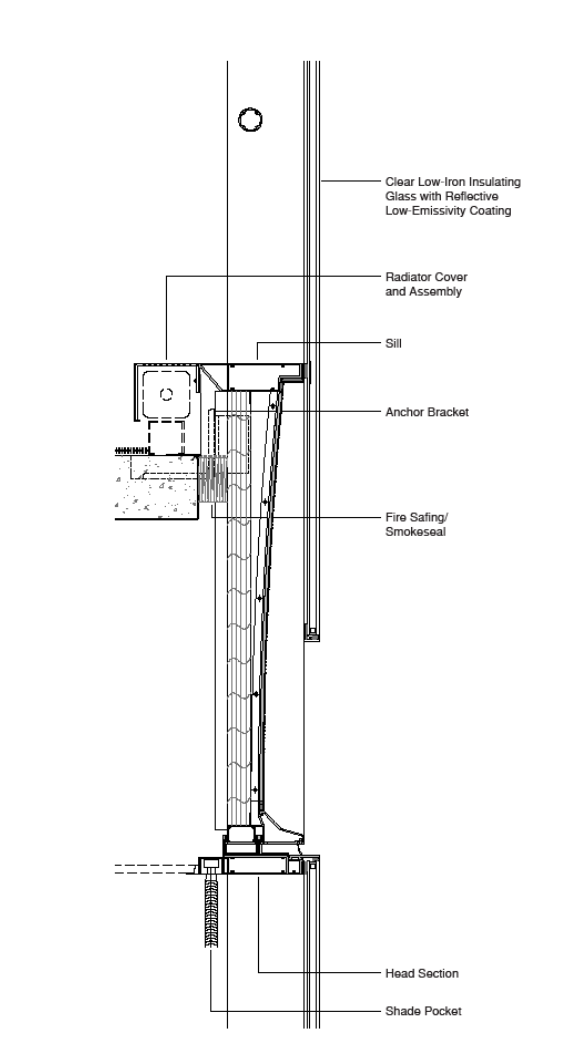
Figure 14: diagram of the ‘linear lap’ curtain wall